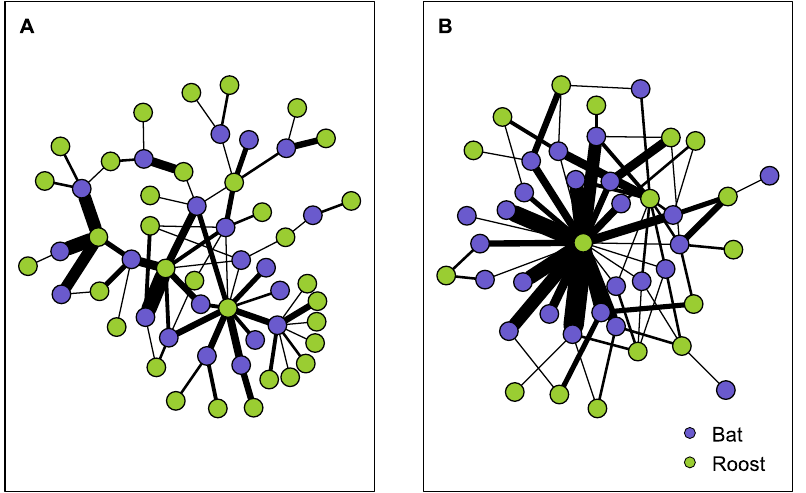
Figure 3. Indiana bat ( Myotissodalis ) roost network maps. Two-mode network maps of an Indiana bat maternity colony in Pickaway County, Ohio, USA, 2009 (A) and 2010 (B). Node type indicated by color, edge width scaled by the number of connections.